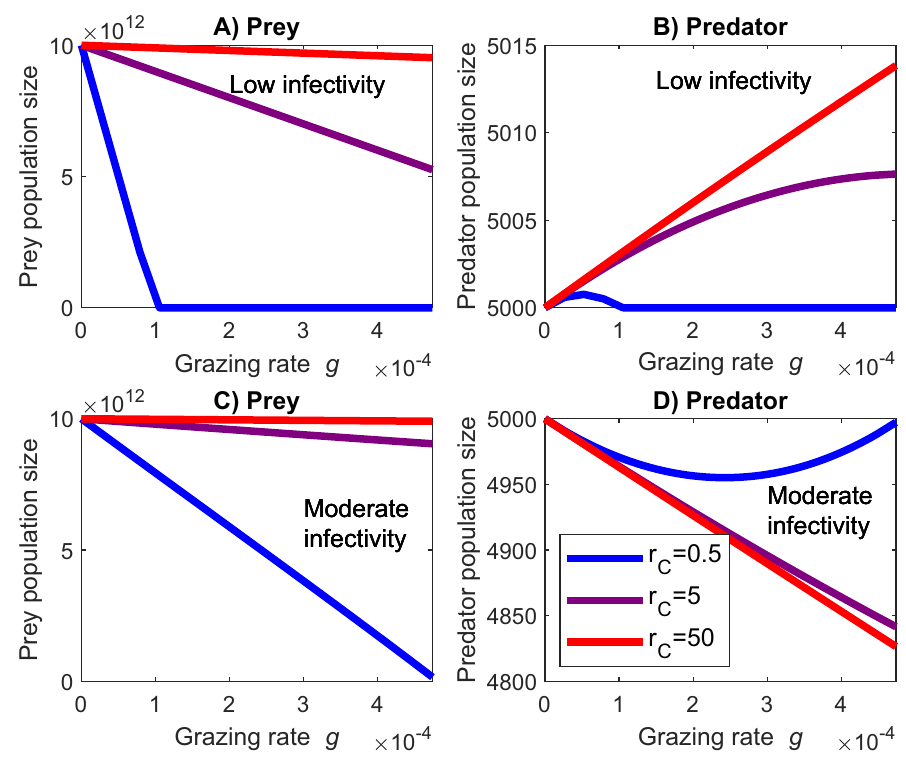
Fig 4. An increase in the infectivity may reverse the effect of predator grazing rate on the predator population size. (A) and (B) The prey’s infectivity e SI is low. Increasing the predator grazing rate g decreases prey and increases predator population sizes. (C) and (D) In contrast, if e SI is slightly greater, then increasing grazing rate decreases the population levels of the prey as well as of the predator. Red, purple and blue lines are fast (r C = 50), medium (r C = 5) and slow (r C = 0.5) growth rates. The infectivity values are e SI = 10 − 13 in subfigures A and B, and e SI = 10 − 10 in subfigures C and D.